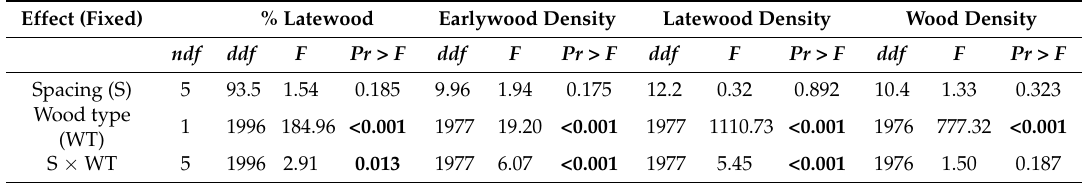
Table 4. Analysis of variance (ANOVA) results for jack pine percentage of latewood, earlywood, latewood, and average wood density 25 years following planting in eastern Canada. ndf : numerator degrees of freedom, ddf : denominator degrees of freedom; calculated using the Kenward-Roger method. Wood type refers to juvenile or mature wood. Bold indicates significance ( p ≤ 0.05).